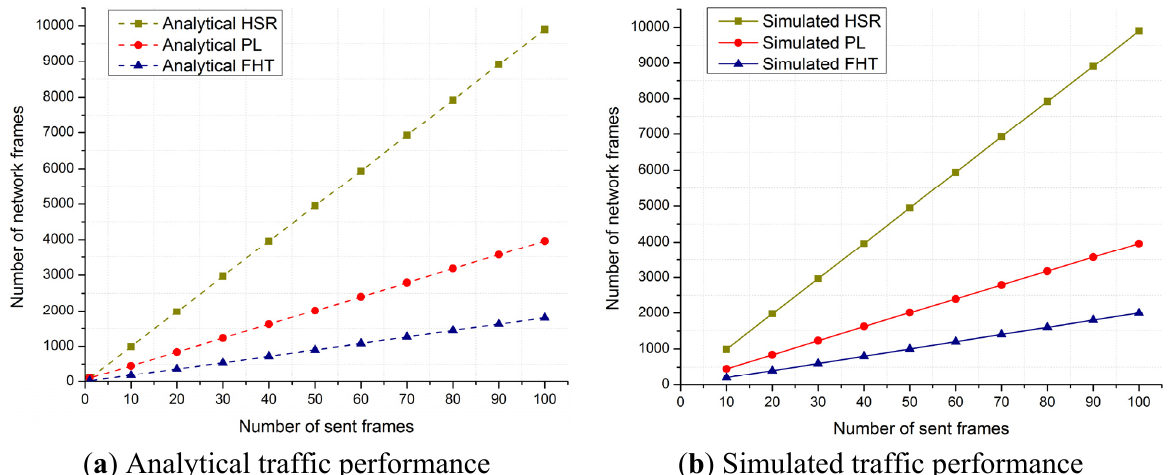
Figure 17. Comparison of analytical and simulated traffic performance between HSR, PL, and FHT in Case 1.